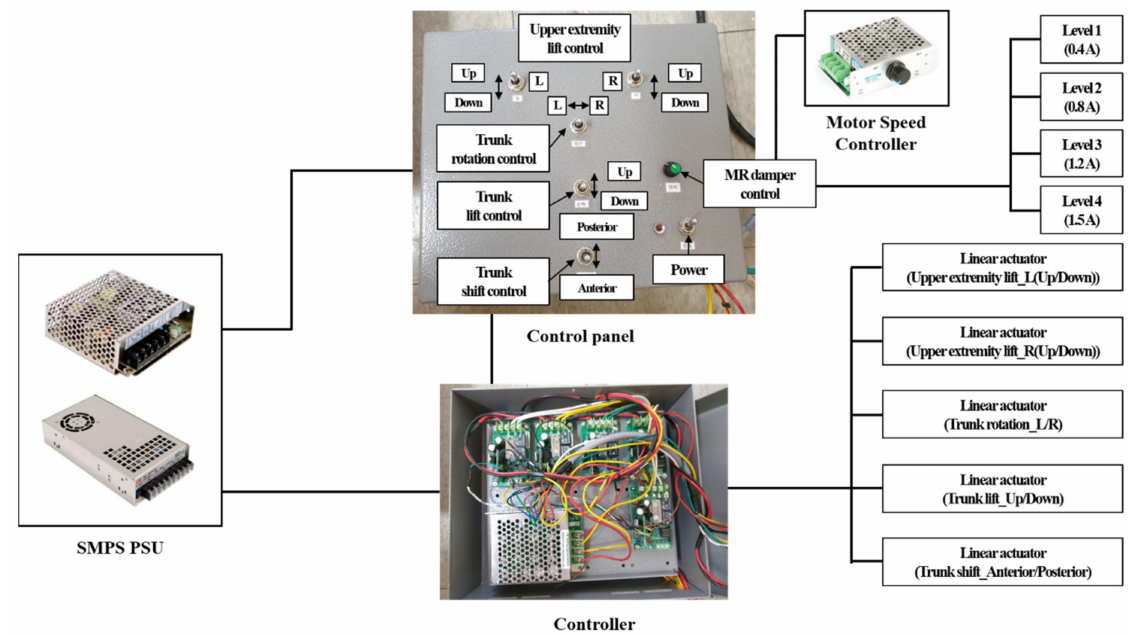
Figure 2. Overview of the rehabilitation exercise